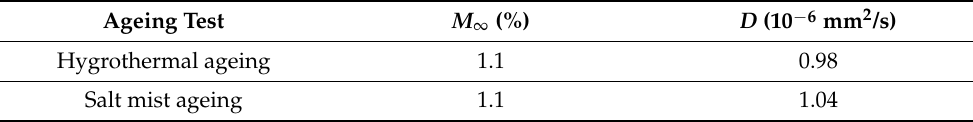
Table 3. Diffusion coefficients under different ageing conditions.